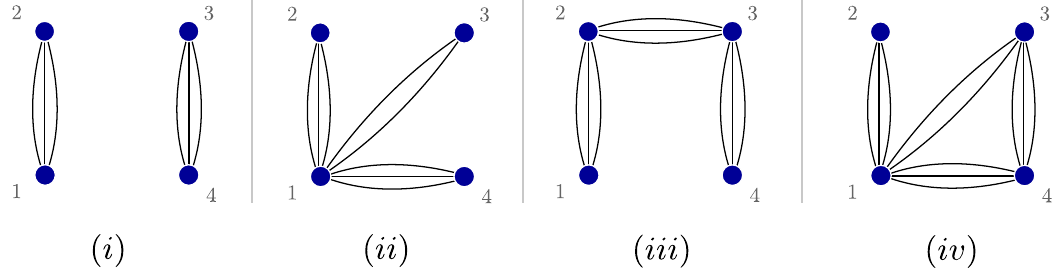
Figure 9 . Four classes of one-edge reducible graphs; each graph can be disconnected by cutting a single edge with however many